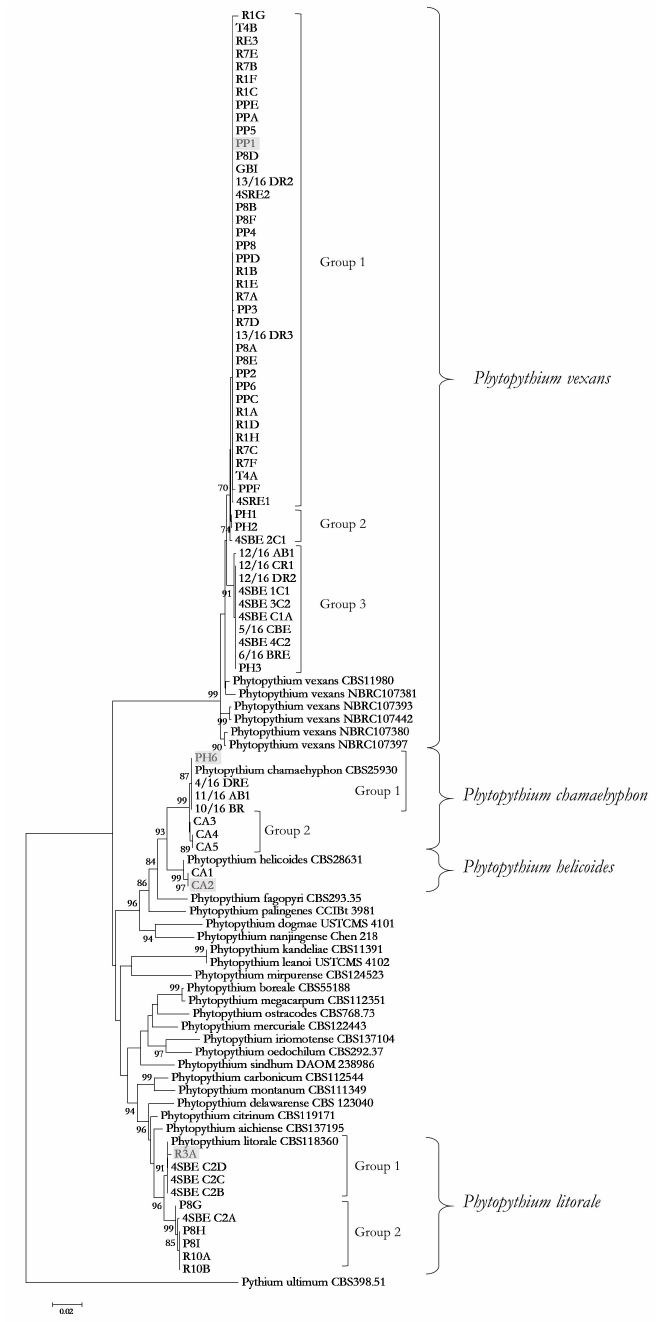
Figure 2. Best scoring Maximum Likelihood tree based on the concatenated ITS, LSU, and COI sequence datasets. The numbers at the major nodes indicate the bootstrap value from 1000 bootstrapped datasets. Branches with lower bootstrap values than 70% are not shown. Phylogeny was rooted by Pythium ultimum . Evolutionary analyses were conducted using MEGA, version 6. The highlighted strains are the isolates used for pathogenicity test.